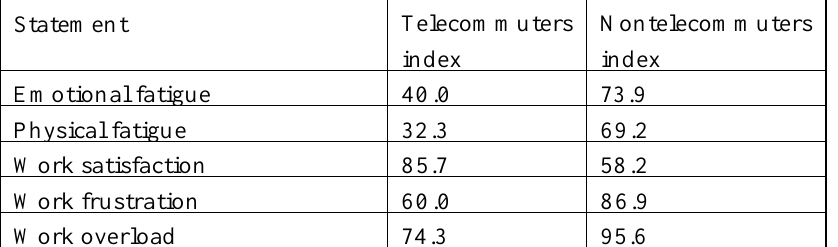
Work Symptoms Experiences by Telecommuting and Nontelecommuting